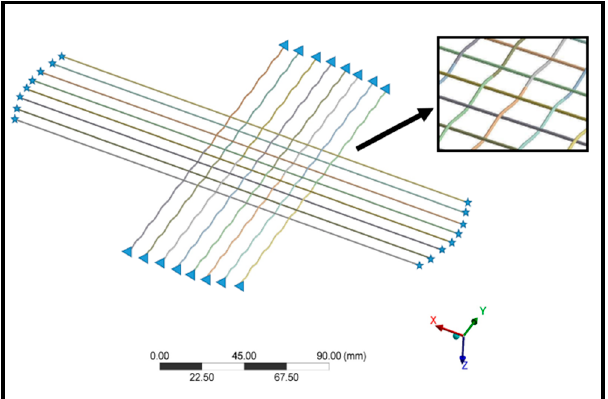
Figure 1. Parts of string-bed model on badminton